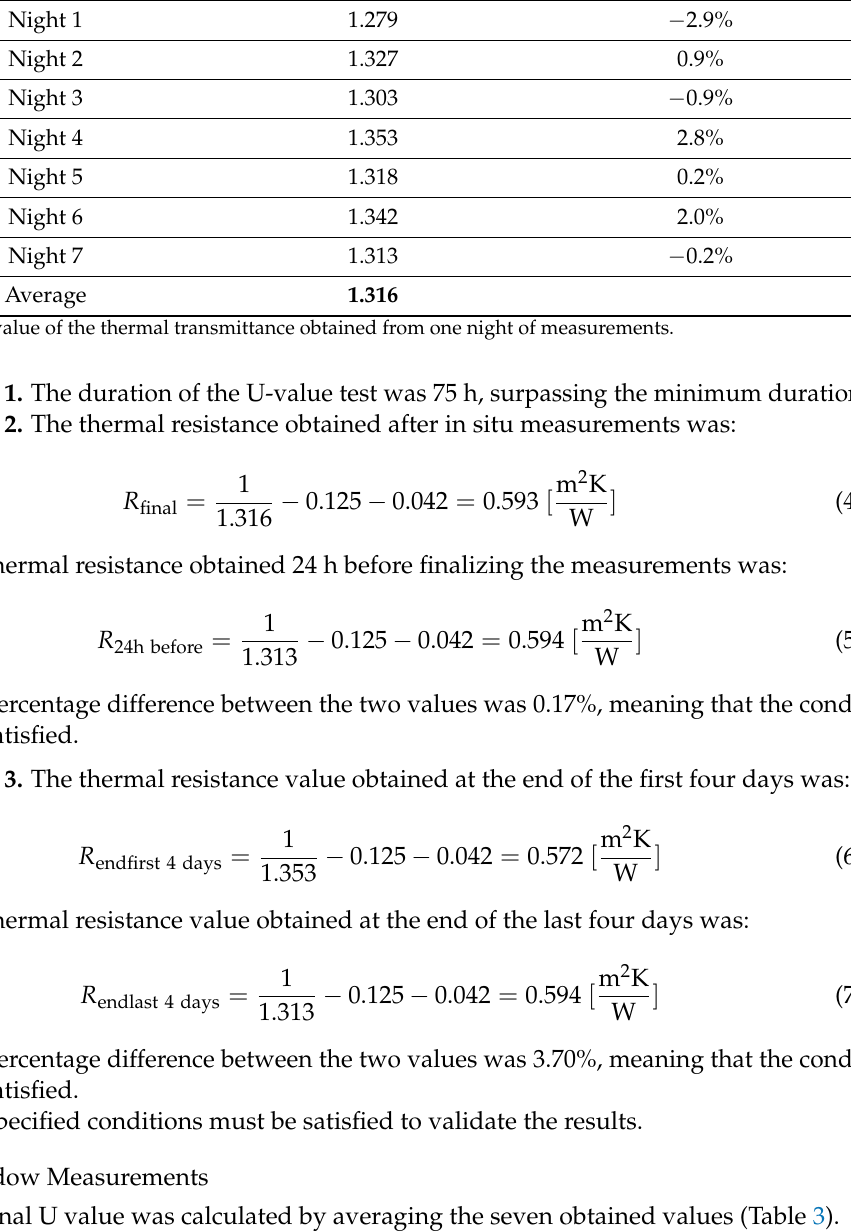
Table 2. Average nigh value of the thermal transmittance for the exterior wall. Percentage Difference from U (W/m 2 K) the Average Value (+/ − %) Night 1